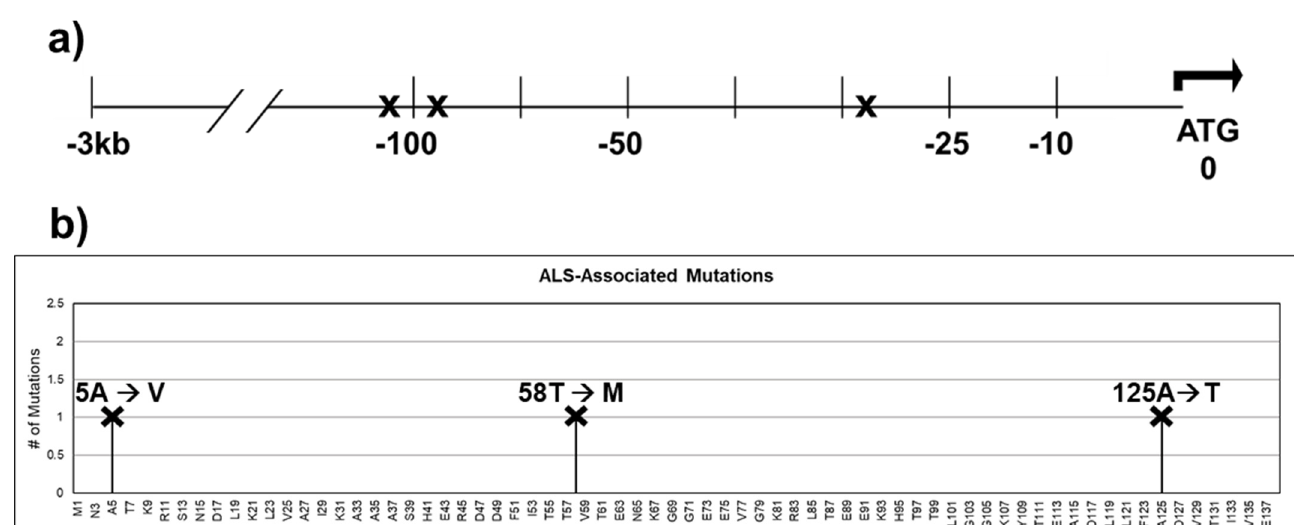
Figure 5. SNPs identified within the 3 kb upstream regulatory region and the coding sequence of CRABP1 in ALS patients. ( a ) Gene diagram of the 3 kb upstream region of CRABP1 with SNPs denoted by “X”. ( b ) Lollipop plot indicating the location of amino acid mutations as a consequence of ALS-associated SNPs. Altered residues are marked above each lollipop.